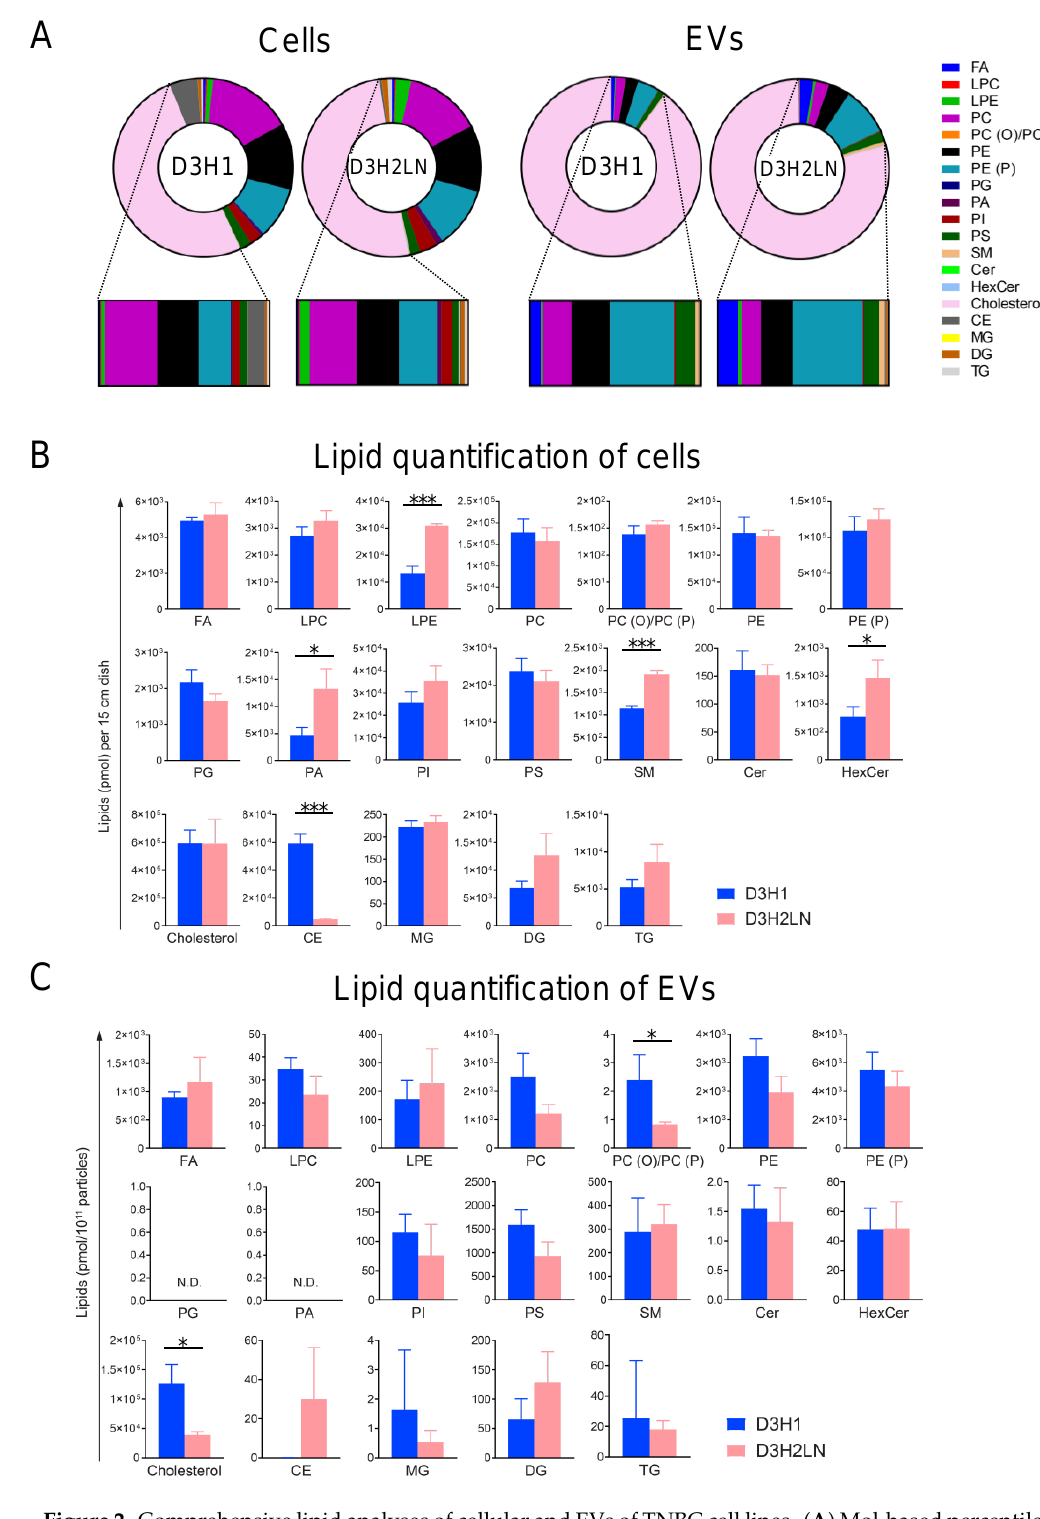
Figure 2. Comprehensive lipid analyses of cellular and EVs of TNBC cell lines. ( A ) Mol-based percentile of each lipid class in cellular and EVs of D3H1 and D3H2LN cell lines. Mol percentage to the sum of all detected lipids was calculated. ( B ) Comparison of the absolute amount of lipid classes between D3H1 and D3H2LN in ( B ) cells and ( C ) EVs (subtracted by mock sample, normalized to particle number). The bar graphs indicate the mean ± SEM of 3 independent replicates. N.D. indicates not detected. *** p < 0.001, ** p < 0.01, * p < 0.05, Student’s t-test (unpaired, two-tailed).